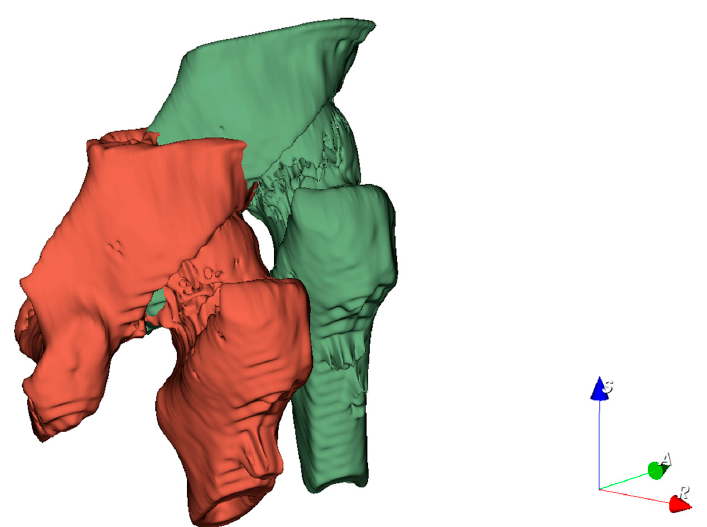
Figure 3. Models generated from different series of CT images are placed in the same coordinate system.